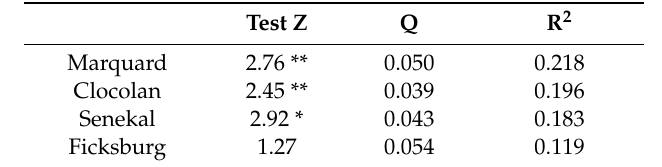
Table 8. Annual maize yield trends during the study period from 1985–2016. MK Test Z denotes the Mann Kendall trend analysis test, and Q denotes ‘the Sen’s slope estimate’. Test Z Q R 2